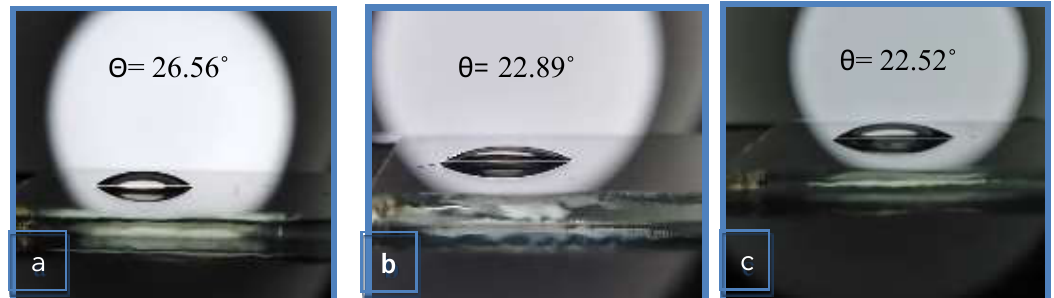
Fig.7a: Images of water droplet on the sample pure TiO b- after15 min. of UV irradiation c-an hour UV irradiation .